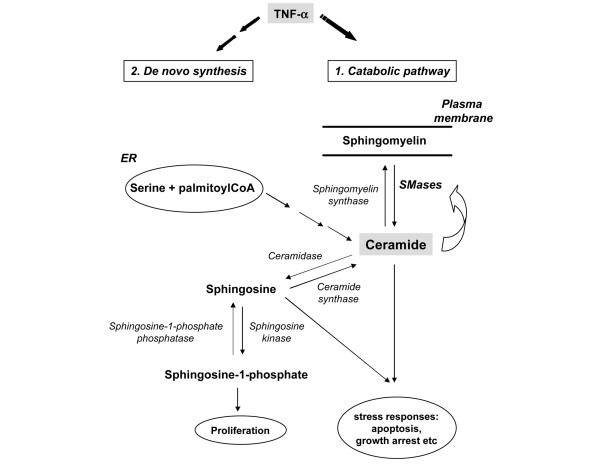
Metabolic pathways involved in the production of endogenous ceramide. Endogenous ceramide is produced via 2 main mechanisms: a catabolic pathway, involving the hydrolysis of the membrane lipid sphingomyelin by endosomal acidic and membrane-bound neutral SMases; and de novo synthesis. TNF-α can increase cellular ceramide via both mechanisms. The rise in ceramide can create a positive feedback loop to amplify ceramide production further via the activation of SMases. Once generated, ceramide can transiently accumulate within the cell or be converted into various metabolites such as sphingosine and sphingosine-1-phosphate. Cell responses to ceramide will therefore depend on the engagement of downstream effectors, the cell microenvironment and concomitant activation of enzymes that convert ceramide into other metabolites. CoA, coenzyme A; ER, endoplasmic reticulum; SMase, sphingomyelinase; TNF, tumour necrosis factor.